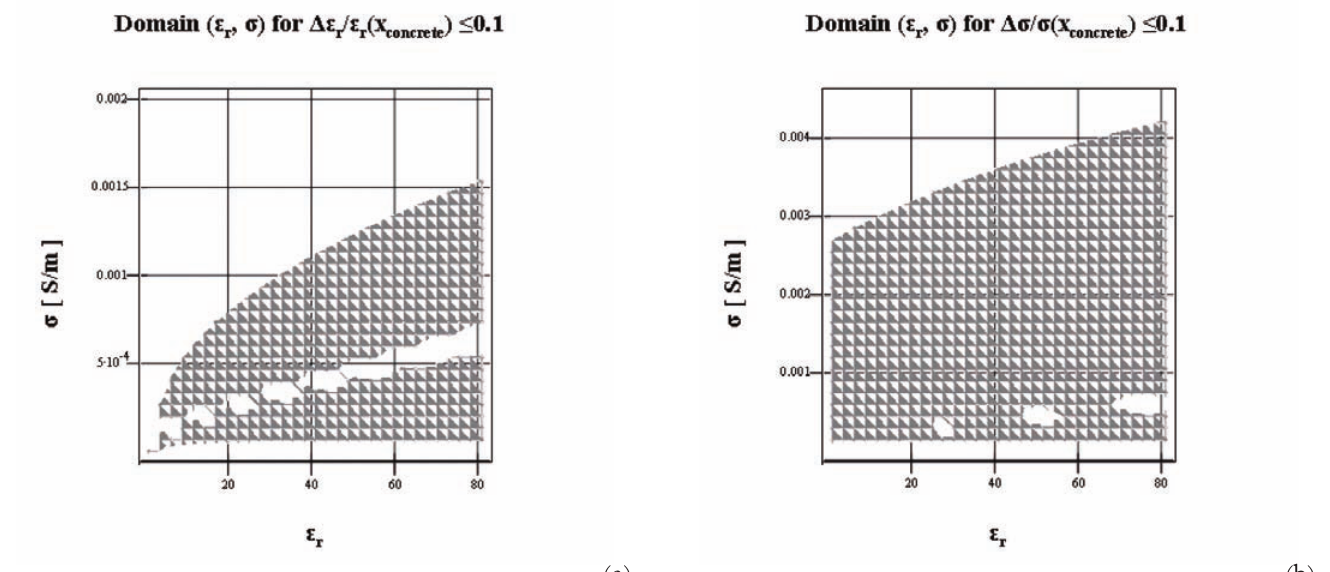
Figure 10. On the hypothesis that D | Z |/| Z |= DU / U = 10 −3 , referring to both the inaccuracies Dv / v ( v , f ) for the electrical conductivity v , and Z Z r Df r / f r ( v , f r ) for the dielectric permittivity f r , as functions of v and f r , and when the quadrupole probe is designed in the linear Wenner configuration working in a fixed band B = 100 kHz, with an height/dimension ratio x = 0.087 which is optimal for capacitive contact only with a non-saturated W, concrete concrete of permittivity f = 4: (a, b) as plots for the orthogonal projections over the ( v , f ) plane that satisfy the conditions Dv / v ( v , f ) ≤ 0.1 (a) and r r r Df r / f r ( v , f r ) ≤ 0.1 (b). See also Tables 1 and